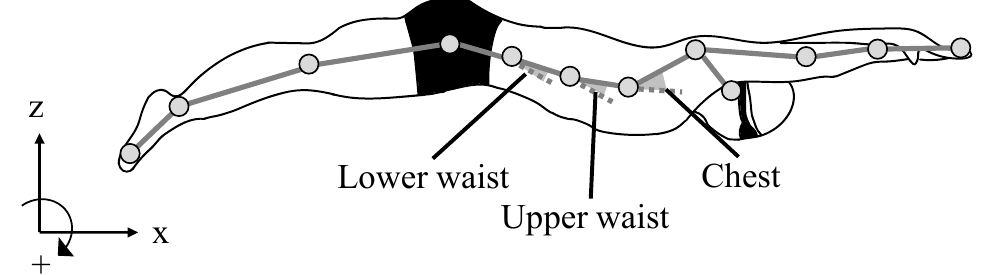
Figure 2. The whole-body segments model.